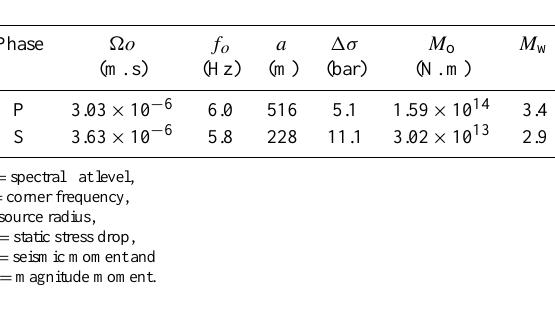
Table 5. Results of spectral parameters from the largest earth- quake in Peñamiller, which occurred on 8 February 2011